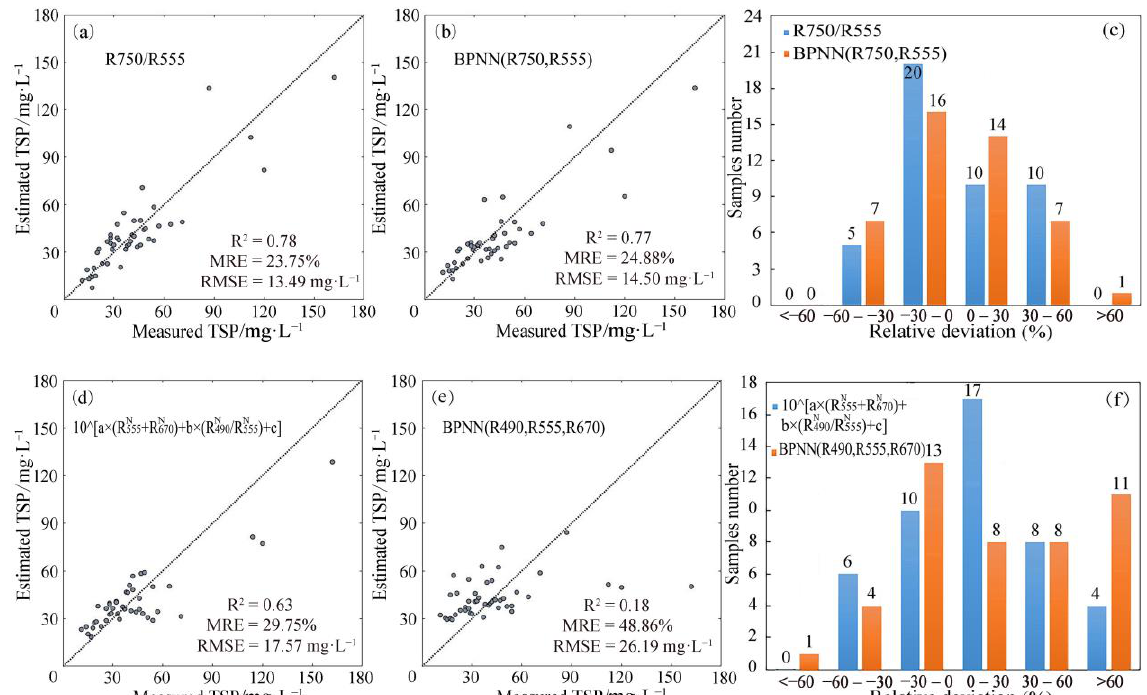
Figure 4. Scatter plot (the dotted line is the 1:1 line) for ( a ) The ratio model (R750/R555), ( b ) The BPNN model (R705, R670), ( d ) The three-band statistical model, ( e ) The BPNN model (R490, R555, R670) and relative deviation distribution between measured values and retrieval values for ( c ) The two-band combination models, ( f ) The three-band combination models for total suspended particulate (TSP) concentration.